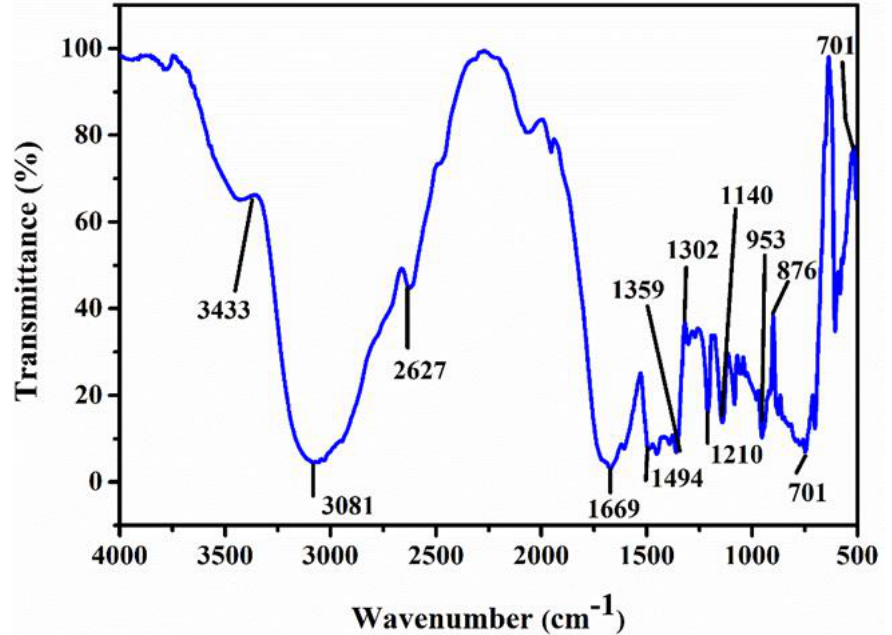
Figure 2. FTIR profile of LPPMA.